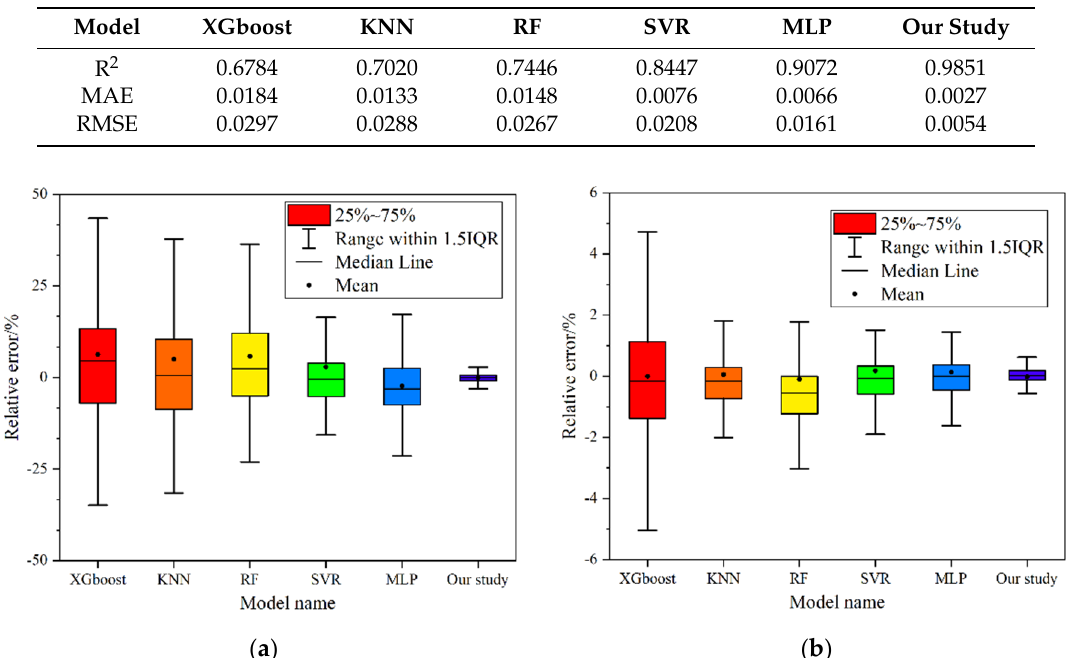
Table 4. Comparison with five classic data prediction methods.